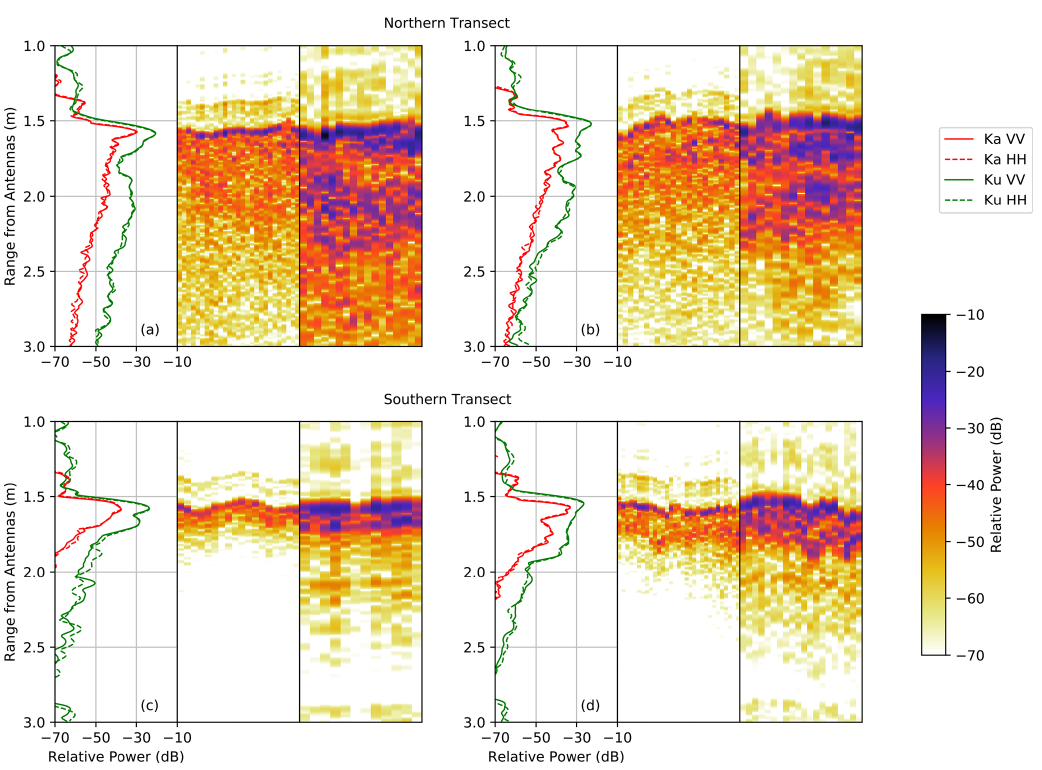
Figure 8. Average VV- and HH-polarized signal power as a function of range at the Ka-band (middle panels) and Ku-band (right panels) for specific locations along the northern (a, b) and southern (c, d) transects as shown in Fig. 7. The difference in the average spectrum between (a, b) and (c, d) is that they are from different locations along the transect and highlight the influence of multiple scattering in the snow and a return from what could be the snow–ice interface at the